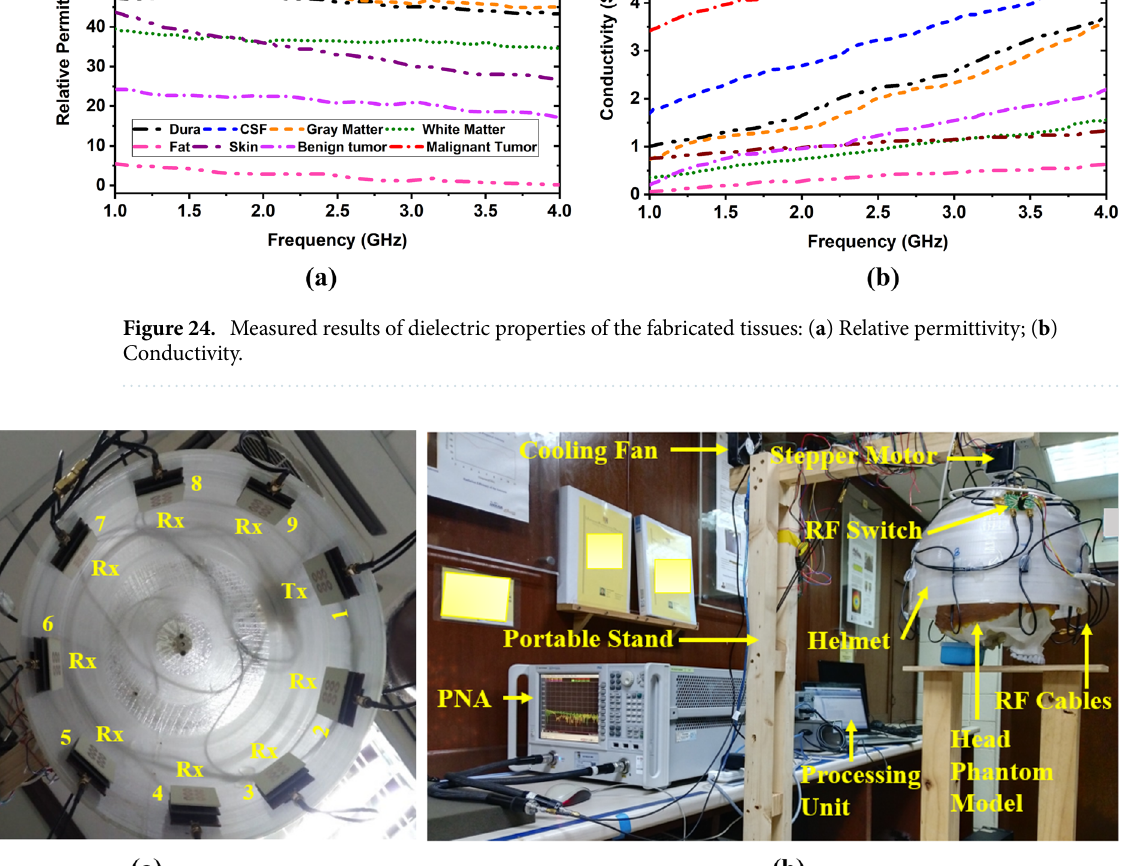
phantom model is placed at the center position of the helmet to verify the system performance. For verifying the outcomes of the system, the simulated and measurement imaging setup and their corresponding reconstructed brain images comparison are presented in Table 7. The Hugo head model is considered for simulation setup and fabricated phantoms with human 3D head skull model is considered for measurement purposes. The benign and malignant tumor(s) with different shapes are inserted in both head models and investigated the imaging performances. For better understanding, the cartesian coordinate system is used to present the geometrical view of the images for finding the localization of the tumor in the images. From the cartesian coordinate (x, y), it is easy to find the location of the tumor in the reconstructed images. The x-axis and y-axis are assumed in mm. For instances, in simulation Setup 2, the location of the benign tumor is (− 12, 12) whereas, in measurement Setup 2, the location of benign tumor is (− 4, 4). However, the tumor locations (i.e., benign and malignant) as a cartesian coordinate in reconstructed images for both simulation and measurement setup are summarized in Table 8. Furthermore, the backscattered signals (i.e., S11, S21, S31, … S91) are collected by the PNA in each 7.2 rota- tion from the system. Later, the collected signals are post-processed and utilized by the Iteratively Corrected Coherence Factor Delay-Multiply-and-Sum (IC-CF-DMAS) image reconstruction algorithm 17 to reconstruct the brain tumor images. This is the improvement of IC-DMAS algorithm and novelties of the used IC-CF-DMAS algorithm compared to other image reconstruction algorithm are (i) It has ability to produce noiseless image with a clear tumor object localization in reconstructed images, (ii) It can reconstruct images with more than one tumor object, and (iii) It takes less computational time to reconstruct brain images. Figure 26a–f represent the non-tumor image (i.e., healthy brain), single benign tumor image, single malignant tumor image, two benign tumors image, two malignant tumors image, and a single benign tumor and a single malignant tumor image, respectively. It is observed that the reconstructed images exhibited very low noises within the regional head area. The proposed MBI system is able to generate images of the brain with target tumors and location. The circular red mark in the images presents the tumor(s) detection and position. The left and bottom side axis labels are used to detect the location of the tumor as a cartesian coordinate. Eight different tumor location(s) are considered in